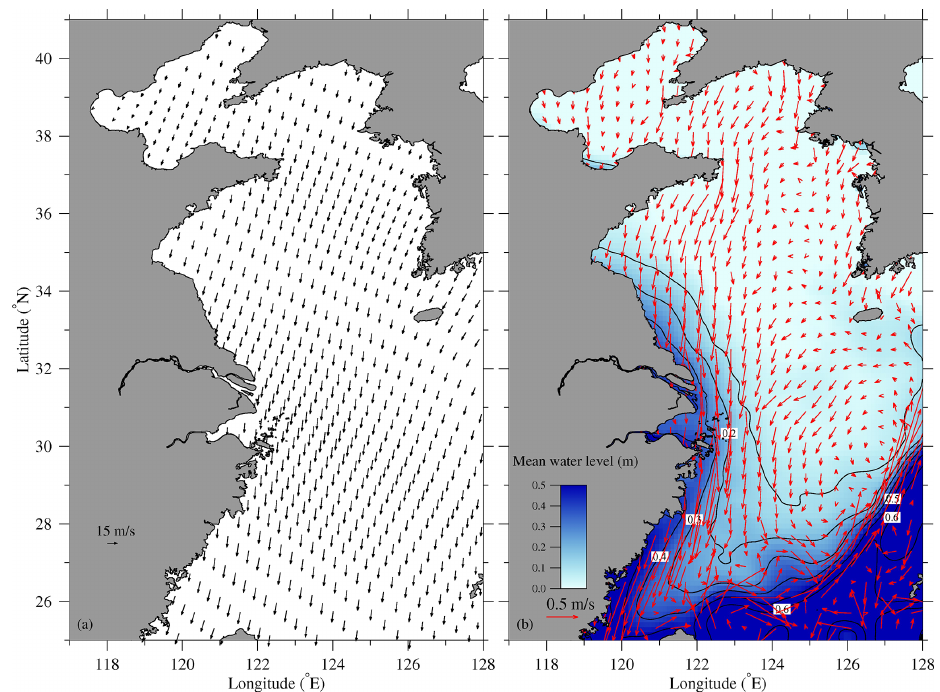
Figure 9. Distributions of the temporally averaged wind field from 7 to 14 February 2014, as simulated by the WRF model (a) , and the time-averaged (mean) water level and surface current from 10 to 13 February 2014, as simulated by the model encompassing the Bohai Sea, Yellow Sea and East China Sea (b)